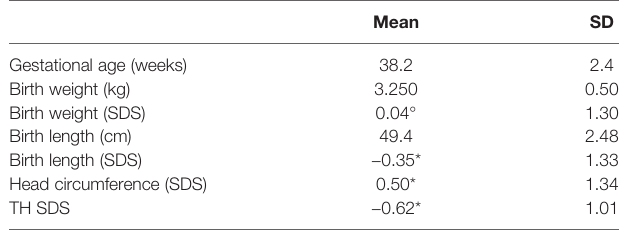
TABLE 1 | Auxological parameters of the entire population at birth.